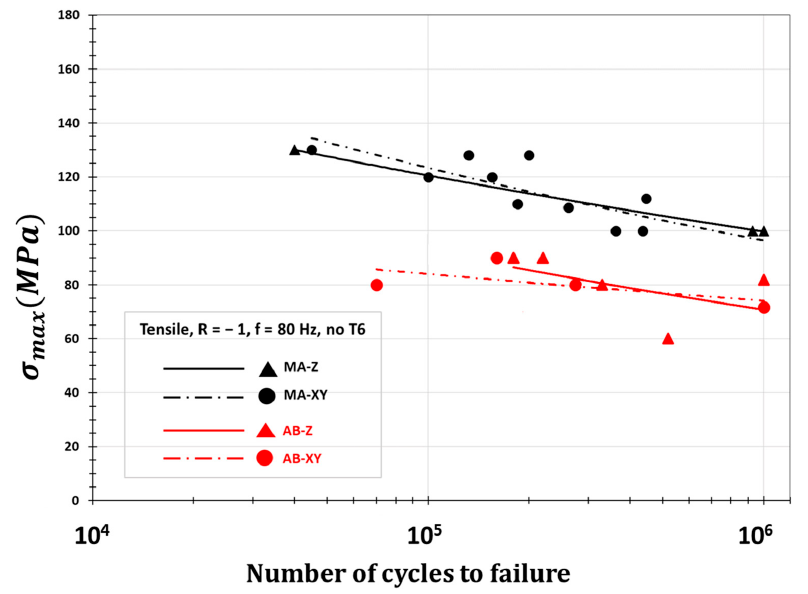
Figure 6. Influence of as-built surfaces and building direction, non-T6 material, comparison with machined [14]; 10 6 : run-out samples.